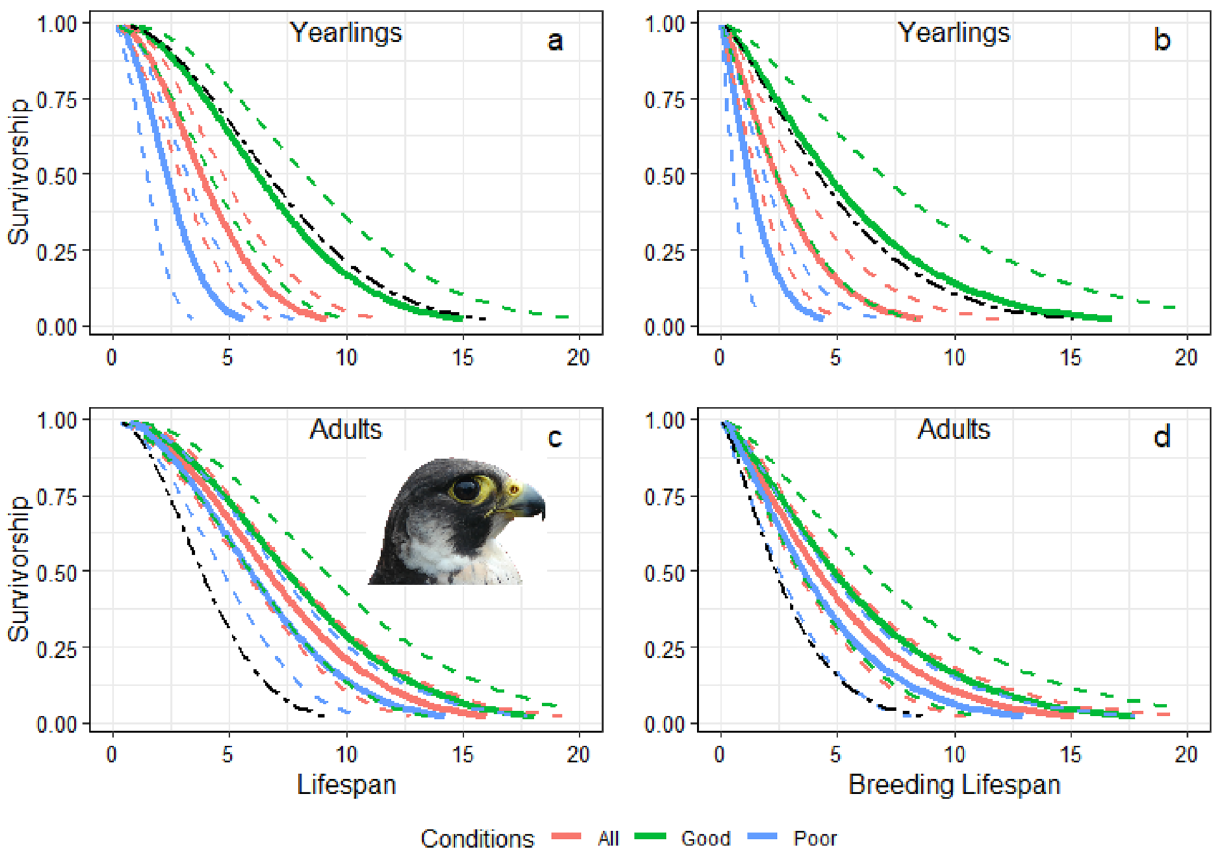
Figure 2. Survivorship and conditions experienced upon recruitment estimated from Accelerated Failure Time (AFT) models. In the top plots, peregrines were recruited as yearlings, and in the bottom ones, those were recruited as adults. The left column shows results for lifespan and the right column results for breeding lifespan. Solid-colour lines indicate survivorship after different conditions upon recruitment (‘All’ model predictions for the average observed conditions upon recruitment; ‘Good’ for average rainfall—standard deviation; ‘Bad’ for average rainfall + standard deviation); broken lines are 95% confidence intervals. The black dot-dashed line shows the all condition average value for the other age-group (peregrines recruited as adults in the plots for these recruited as yearlings and vice versa) and was included to ease comparison. Sample size and their distribution by lifespan lengths are detailed in Table 2. The insert in the bottom-left plot shoes the face of a peregrine falcon, our study